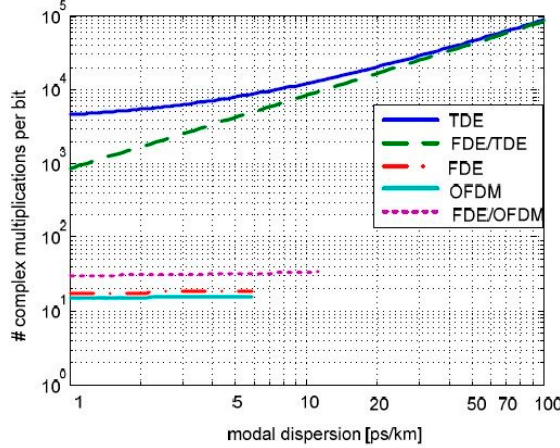
Figure 10. The orthogonal frequency-division multiplexing (OFDM) FDE equalizer complexity requirements compared with other MIMO approaches [37].